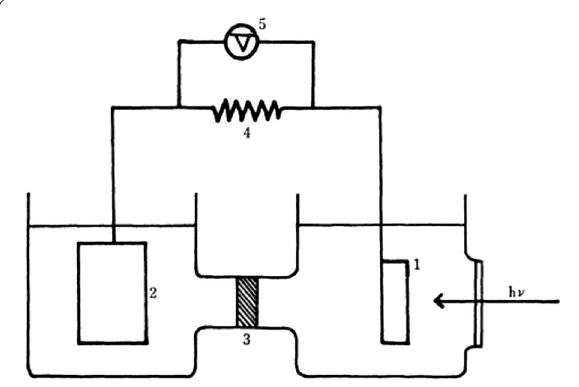
Fig. 6 Illustration of a PEC cell reported by Honda and Fujishima: 1 is a TiO 2 photoanode, 2 is a Pt counter electrode, 3 is a sintered glass diaphragm, 4 is an external load, and 5 is a voltameter. Copyright permission from The Chemical Society of Japan [107]